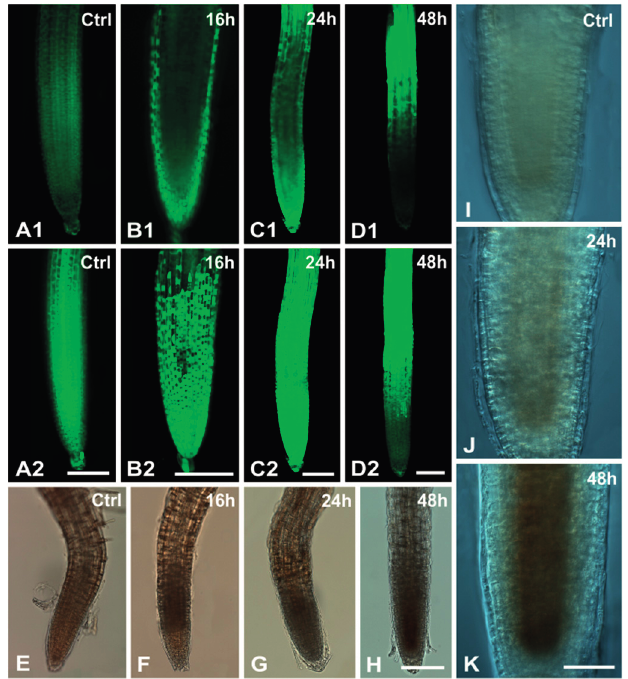
Figure 3. Visualization of H 2 O 2 concentration and peroxidase activity in root tips of A. thaliana . ( A – D ) 2,7-dichlorofluorescein diacetate (DCF-DA) staining of control ( A )